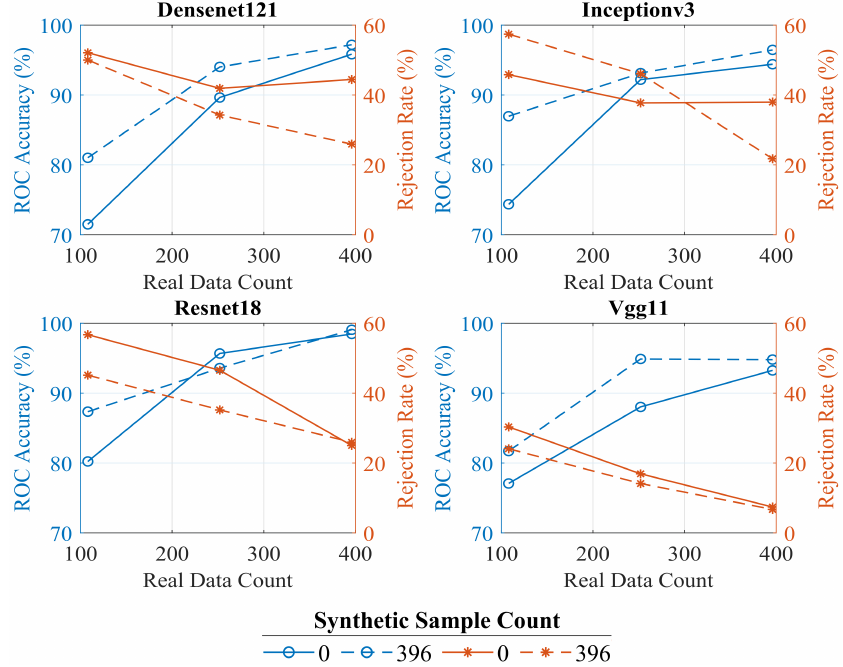
Figure 10. Response of networks after ROC analysis with increasing levels of real data. These results correspond to the configuration pairings C1/C4, C5/C6, and